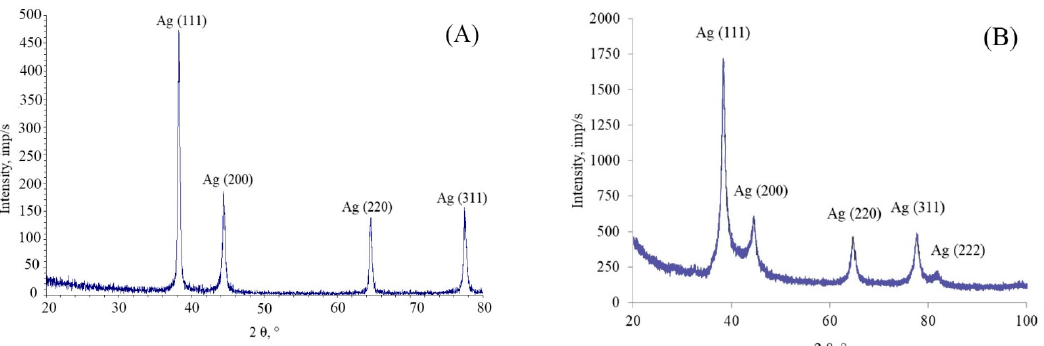
Figure 3. Typical X-ray diffractograms of the irreversibly coagulated silver NPs stabilized with ( A ) BDMMAC (with glucose as the reducing agent), and ( B ) PHMB, with the characteristic peaks corresponding to interplanar distances of the crystalline silver.